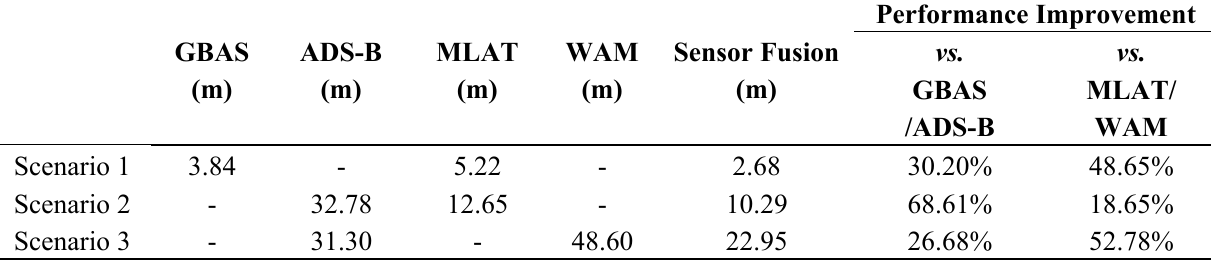
Table 2. Error of each sensor in each